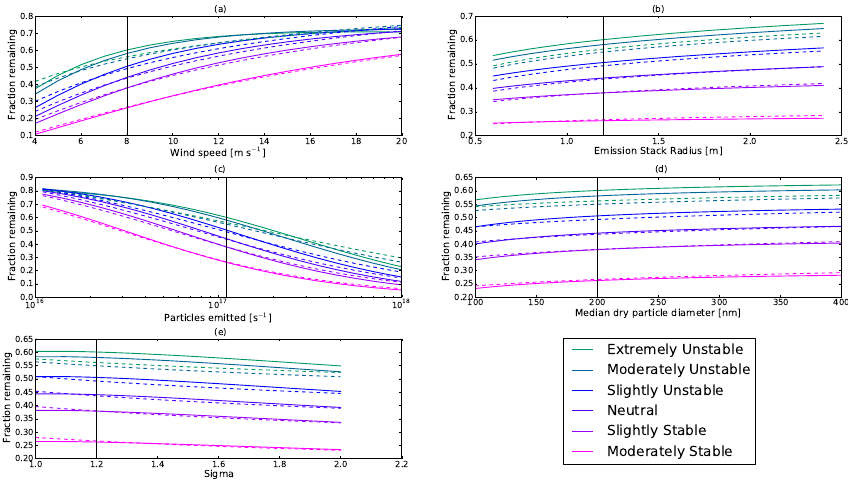
Fig. 5. The dependence of F on each of the varied parameters for all stability classes. In each plot, one parameter is varied while the other four are kept at their base-case values. The full multi-shelled Gaussian plume model results are shown by the solid lines, and the fit parameterization is shown by the dashed lines. The solid black vertical lines indicate the base-case value for each parameter.